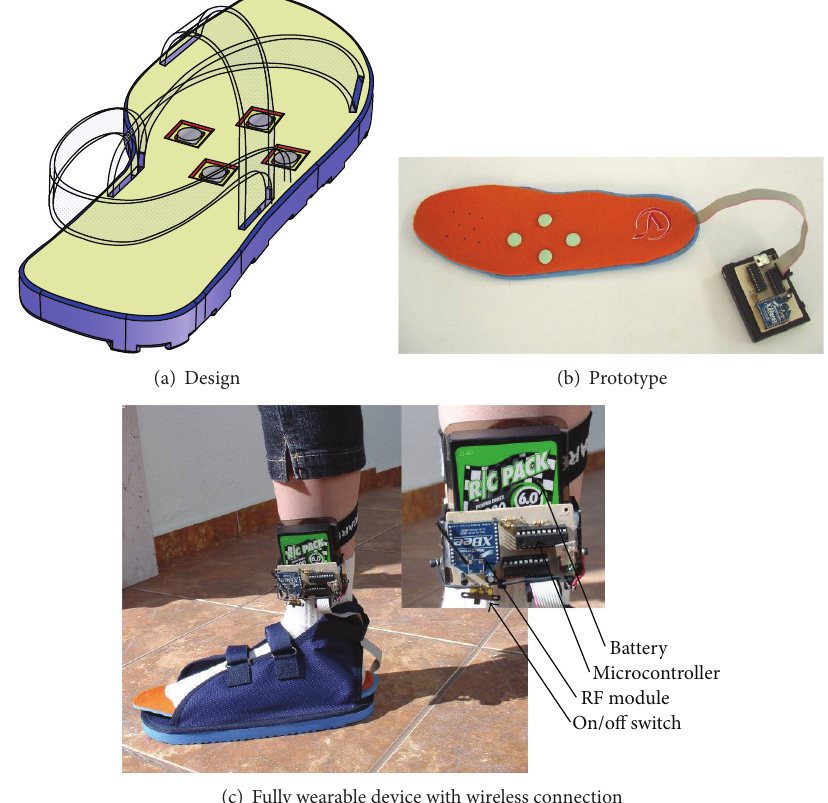
Figure 3: Second prototype of tactile interface for the